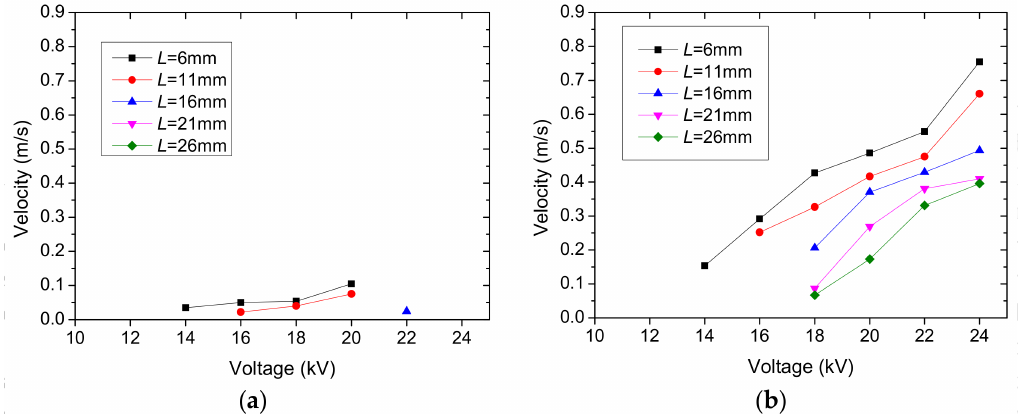
Figure 10. Variation of ionic wind velocity with the applied voltage with different needle-ring distances for three needles: ( a ) positive corona discharge; and ( b ) negative discharge.